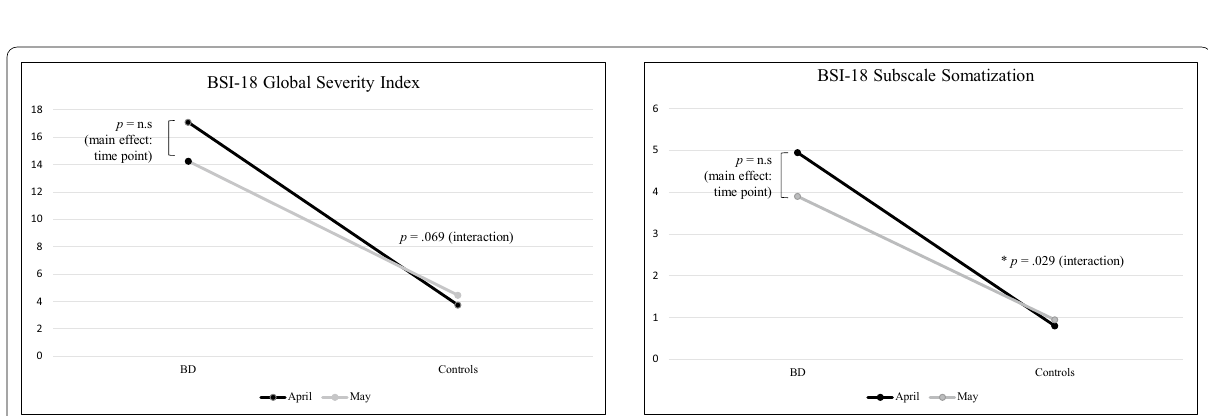
Fig. 3 Main result of the two‑tailed repeated measure ANCOVAs for BSI‑18 somatization and BSI‑18 global severity index (GSI)